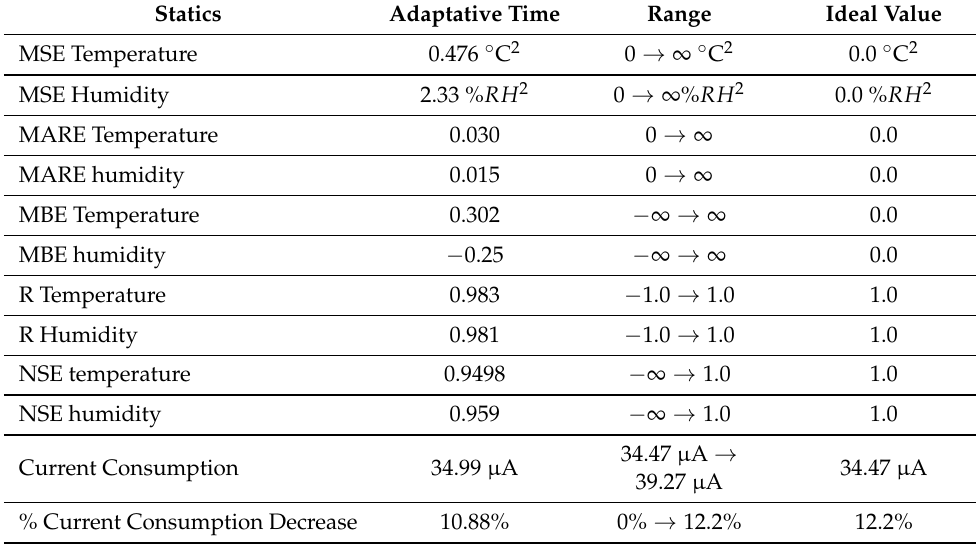
Table 3. Resume Statics for days with different